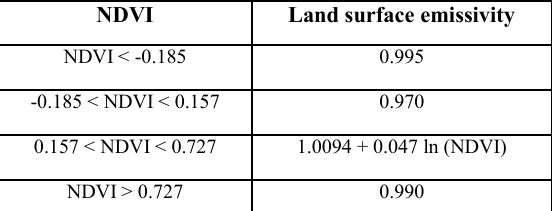
Table 2. Land Surface Emissivity estimation from NDVI